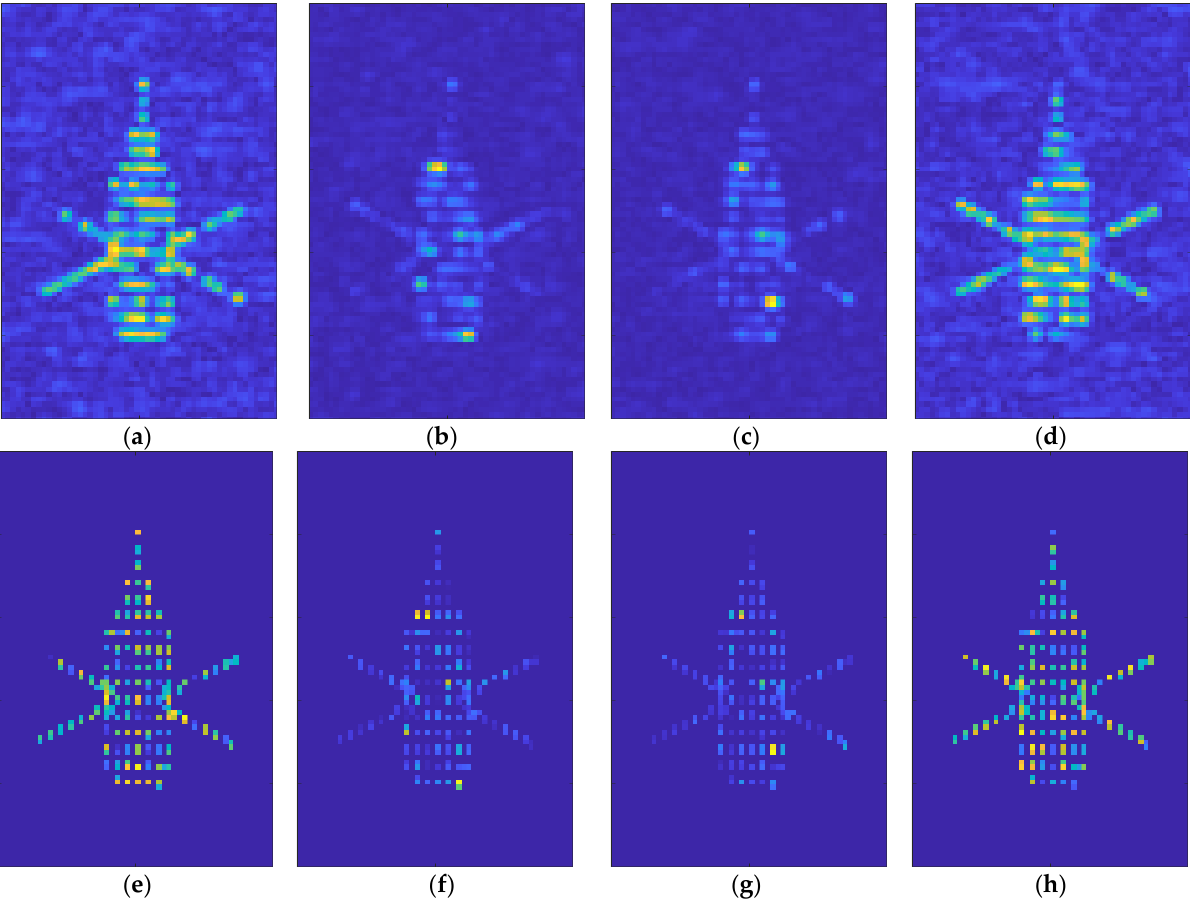
Figure 8. Comparison of reconstructed image between RD algorithm and CS algorithm: ( a – d ) represent the images obtained by RD algorithm in HH, HV, VH and VV polarization channels, respectively; ( e – h ) represent the images obtained by CS algorithm in HH, HV, VH and VV polarization channels, respectively.